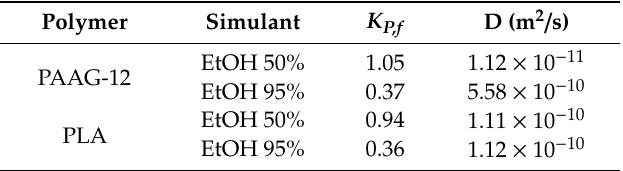
Table 2. Di ff usion ( D ) and partition coe ffi cients ( K P,f ) for α -tocopherol migration from PAAG-12 and PLA films into food